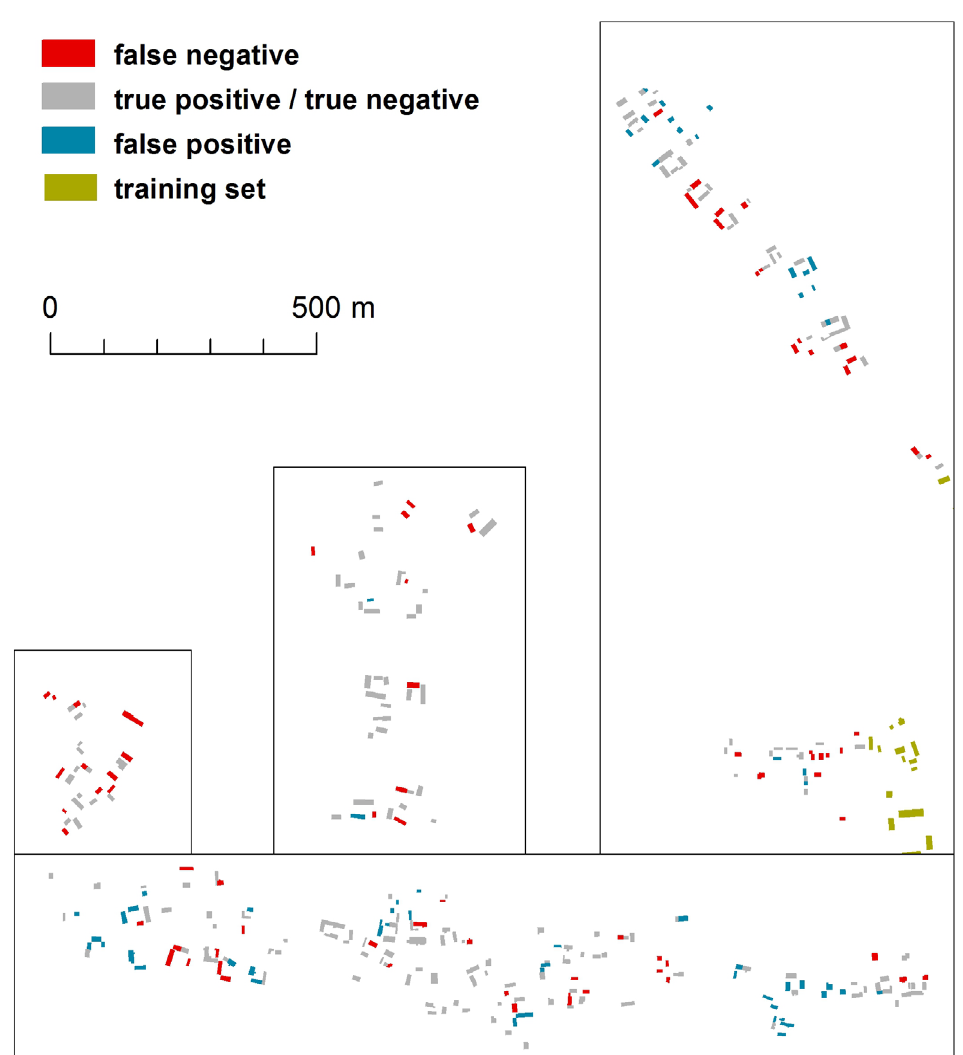
Fig. 9. Results of the selection of buildings using the FRST method in relation to the expected value; Variant B − parts of the “Village” area containing buildings (source: A. Fiedukowicz